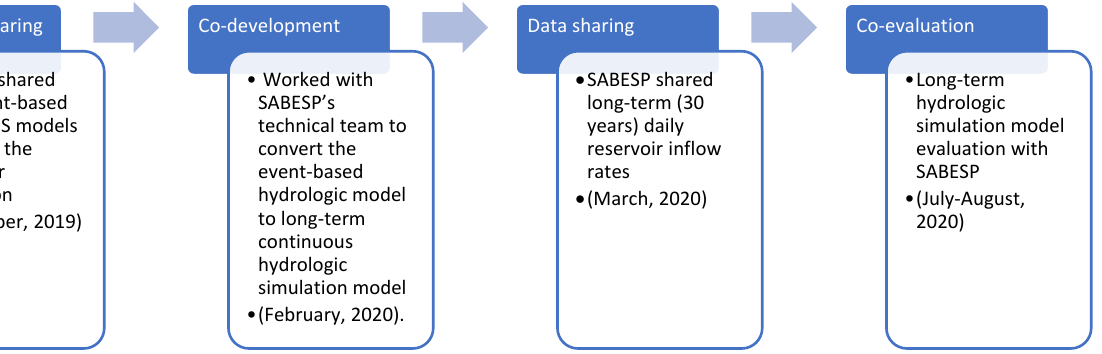
Figure 6. Co-development of long-term hydrologic simulation model over the course of the project by adapting the stakeholders’ existing hydrologic modeling framework.